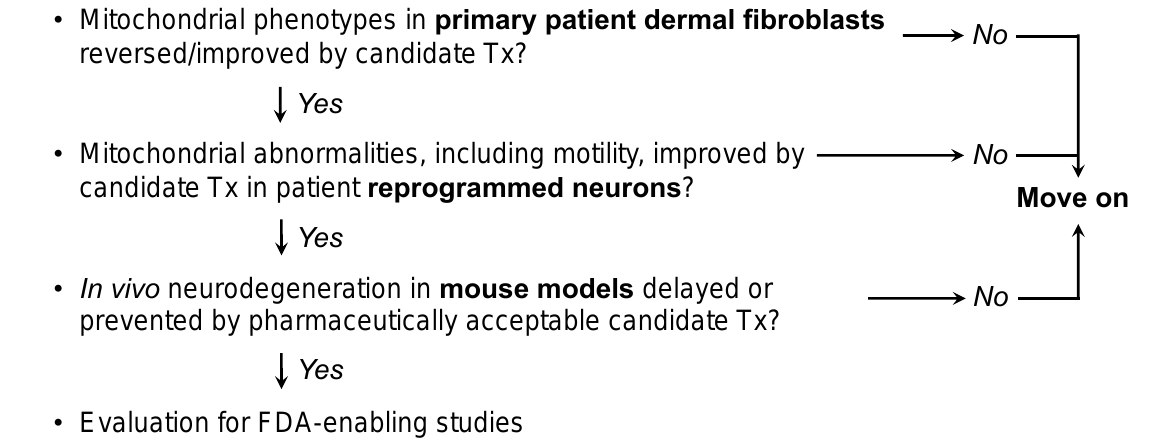
Figure 4. Possible screening procedure using patient-derived cells to evaluate different therapeutics for a given disease, or to assess potential efficacy of a particular approach in multiple diseases.